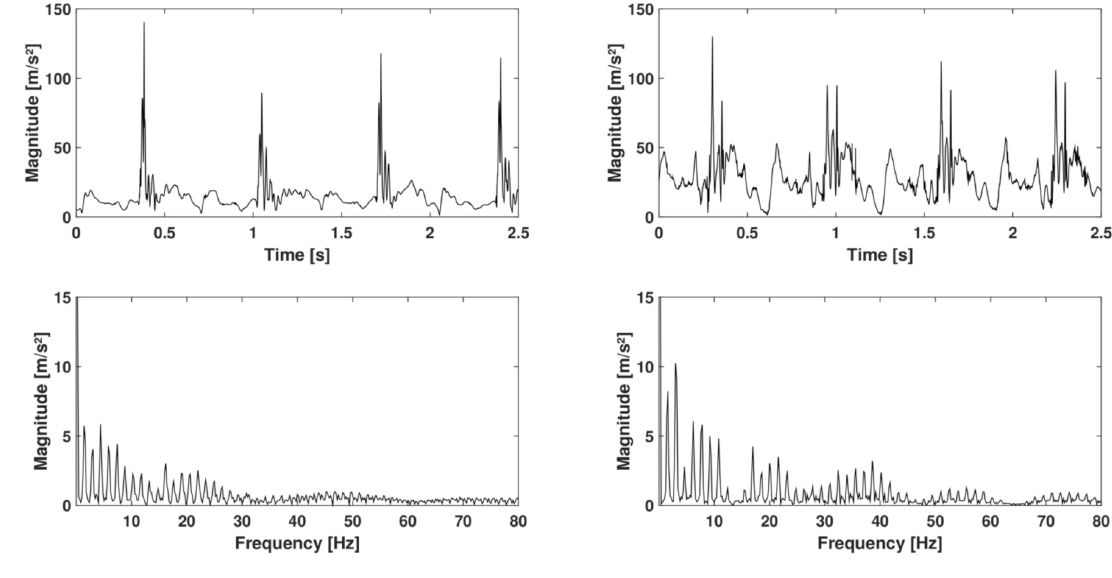
Figure 4. Temporal ( Top ) and frequency ( Bottom ) signals during running, measured by reference R 1344 at 8 km/h (total